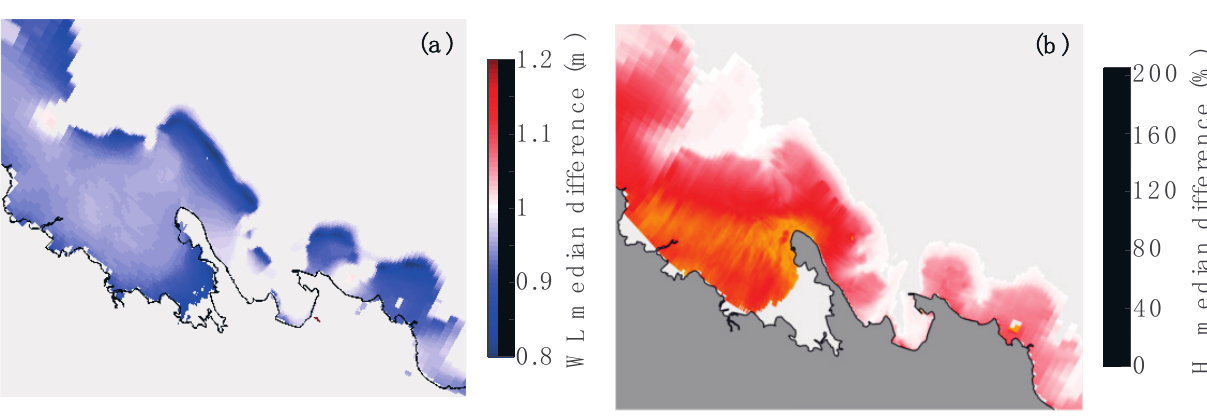
Figure 10. Differences in maximum water levels between “wind”, “wave” and “all” forcing. ( a ): median difference between wind and wave maximas (wind minus wave); ( b ): median differences between the sum of wind and wave maximas (with a correction to prevent double counting tides and inverse barometer) and “all” forcing maximas.